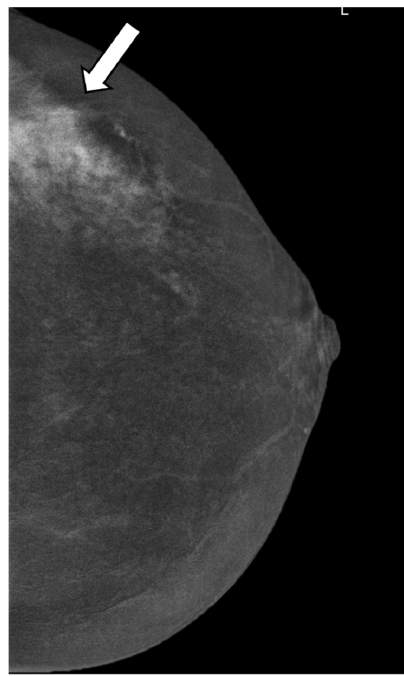
Figure 3. A 41-year-old woman with unilateral hemorrhagic nipple discharge for 1 month. Craniocaudal (CC) view of CESM subtraction images show a non-mass enhancement in the left upper outer quadrant (white arrow) that is moderated, irregular, heterogeneous, and unpurified (enhancement score 4); the histology result shows a high-grade DCIS.